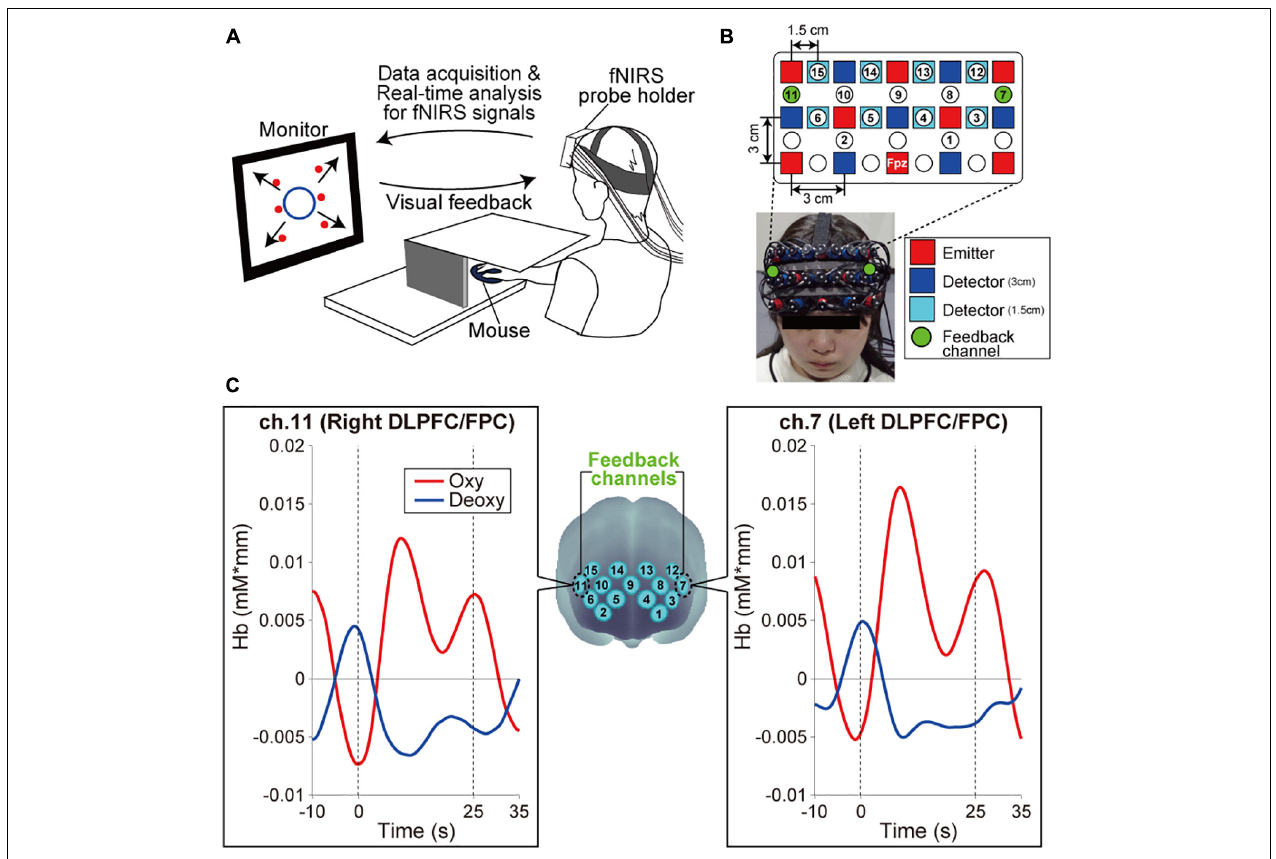
FIGURE 1 | Experimental setup. (A) Neurofeedback training set up. The monitor presented visual feedback on the status of participants’ bilateral prefrontal cortex in real-time. Furthermore, the six red circles on the monitor indicated the visual stimuli that participants were required to remember. Specifically, in each task block, the all-red circles were sequentially presented individually in random order at the predetermined fixed positions {with the center of the monitor as the origin, the coordinates of the six circles were [ x (cm), y (cm)] = (–10, 8), (10, 8), (–10, 0), (10, 0), (–10, –8), and (10, –8)}. The appearance order changed with every task block. The participants were required to remember the spatial appearance order of six visual stimuli on the monitor. (B) Configuration of the fNIRS probe. Probes were placed over the prefrontal area. The channels, numbered 1–15, indicated the channels that output fNIRS signals that have been removed based on multidistance ICA. Ch.7 and ch.11 conveyed signals from the left and right DLPFC/FPC, respectively, as neurofeedback. (C) Spatial registration of the fNIRS maps onto MNI coordinate space. The left and right panels show typical profiles of oxy-Hb and deoxy-Hb in the feedback channels. Time zero indicates the onset of the task block. After starting the task block, the oxy-Hb signal showed a stronger response than the deoxy-Hb